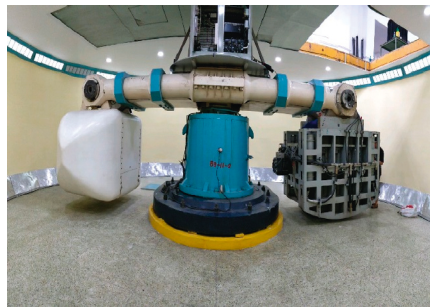
Figure 1: Photo of dynamical centrifuge in